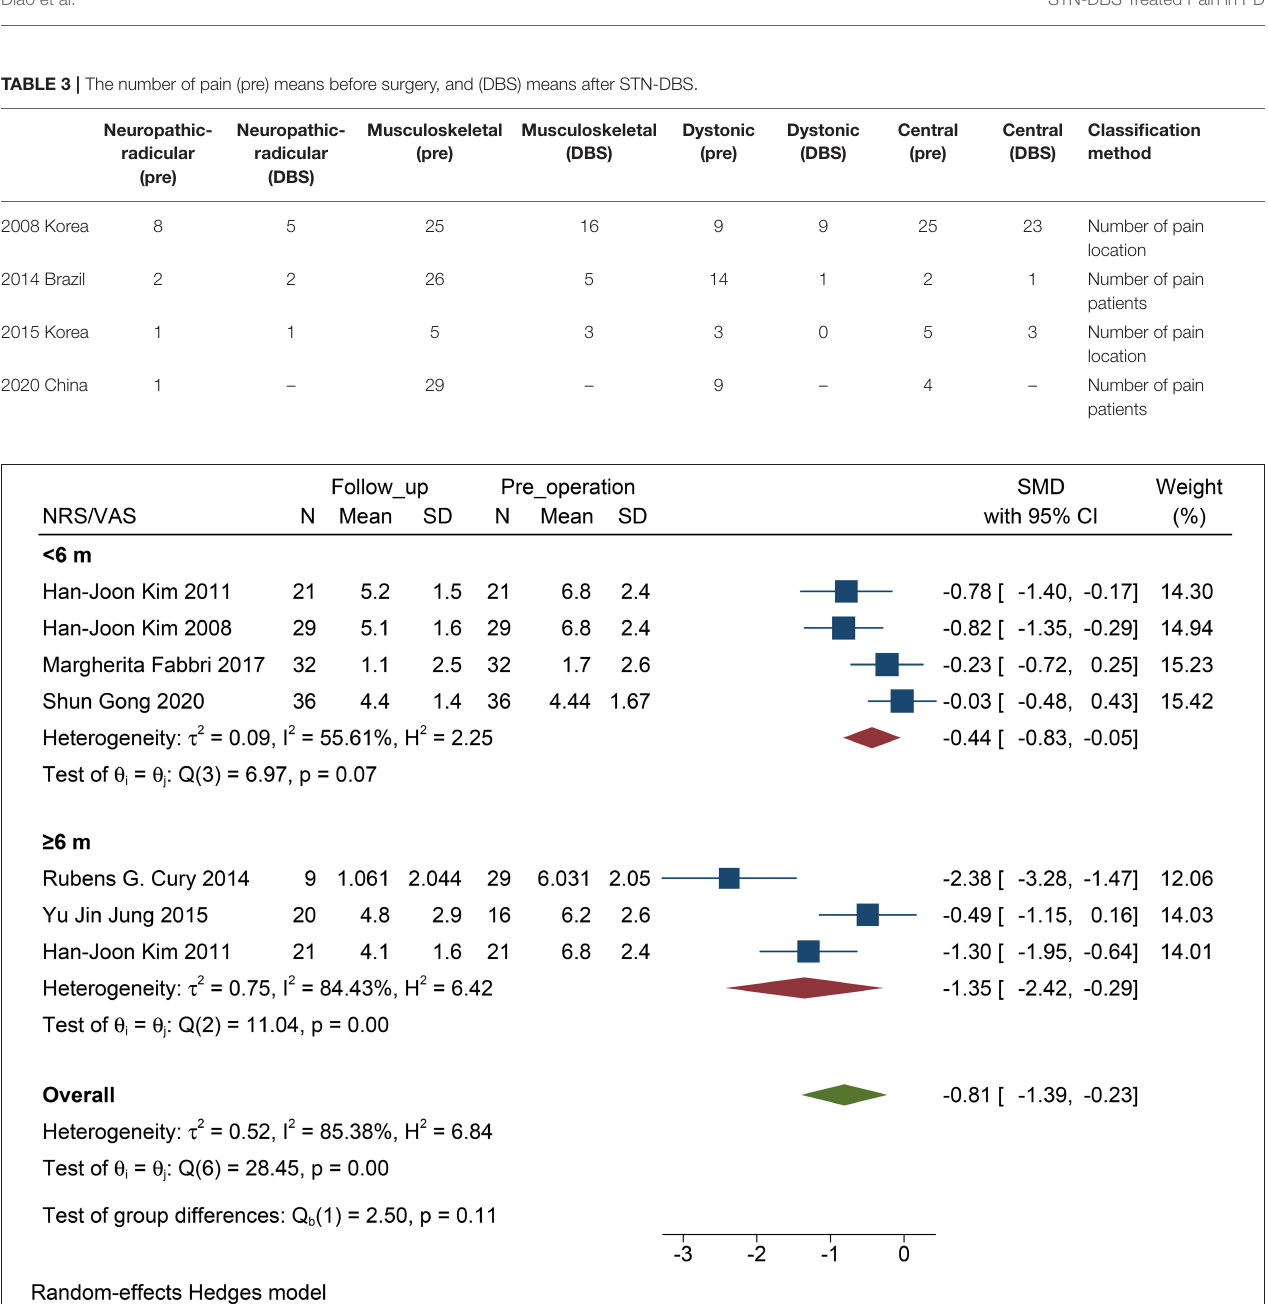
FIGURE 4 | Forest plots of pain severity with PD follow-up subgroups: The SMD of pain severity divided into two subgroups by the time of follow-up accessed by the score of NRS/VAS. Only the long-term subgroup has statistical significance. PD, Parkinson’s disease; NRS, numerical rating scale; VAS, visual analog scale; SMD, standardized mean difference; N, simple size.